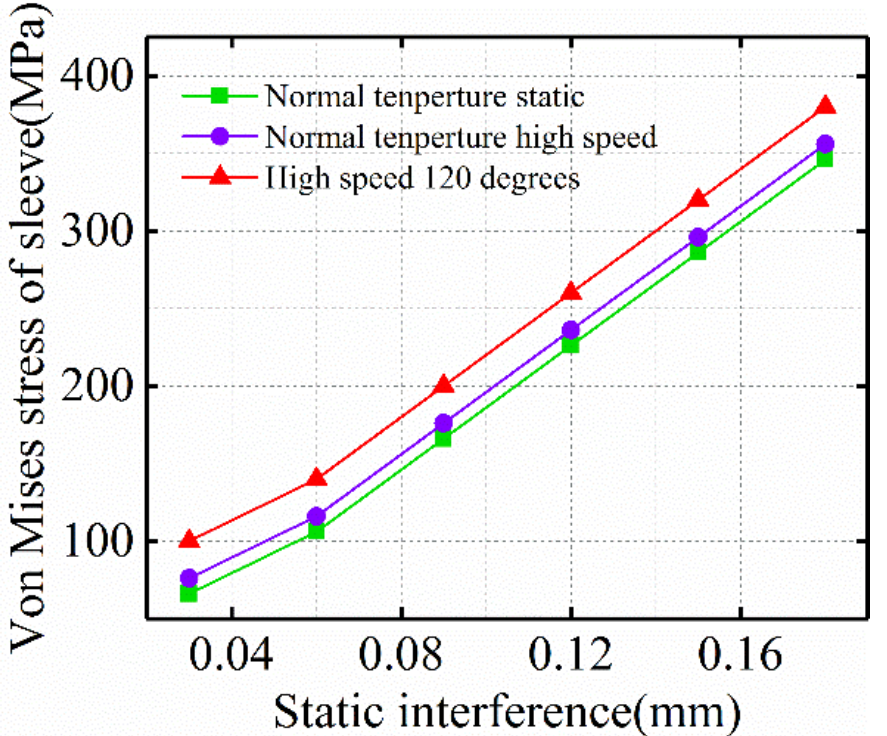
Figure 17. Influence of static interference on sleeve stress.